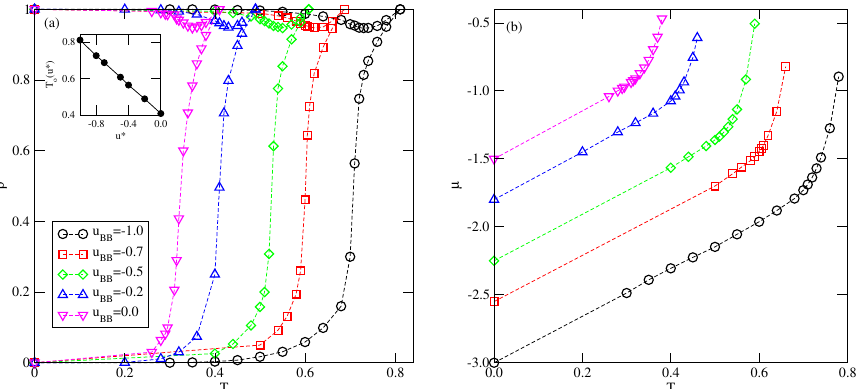
Figure 12. The T − ρ ( a ) and T − µ ( b ) projections of the Bulk phase diagrams for different values of u BB , given in the part ( a ).